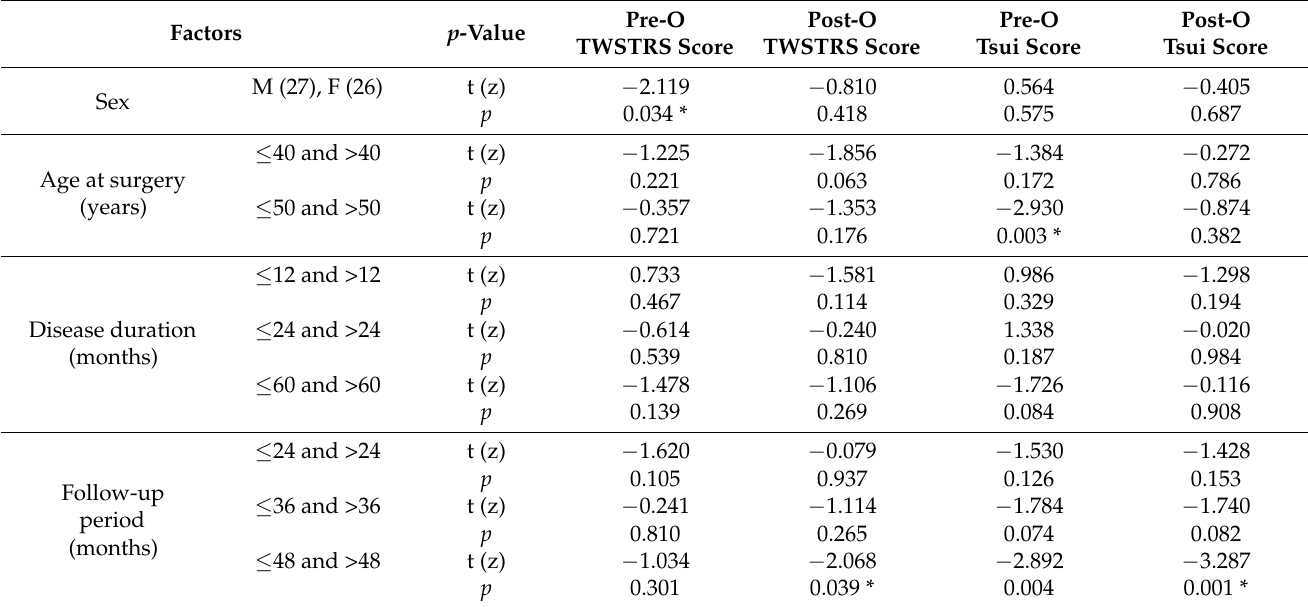
Table 5. Relative improvement in TWSTRS and Tsui scores at the last follow-up after DBS surgery.